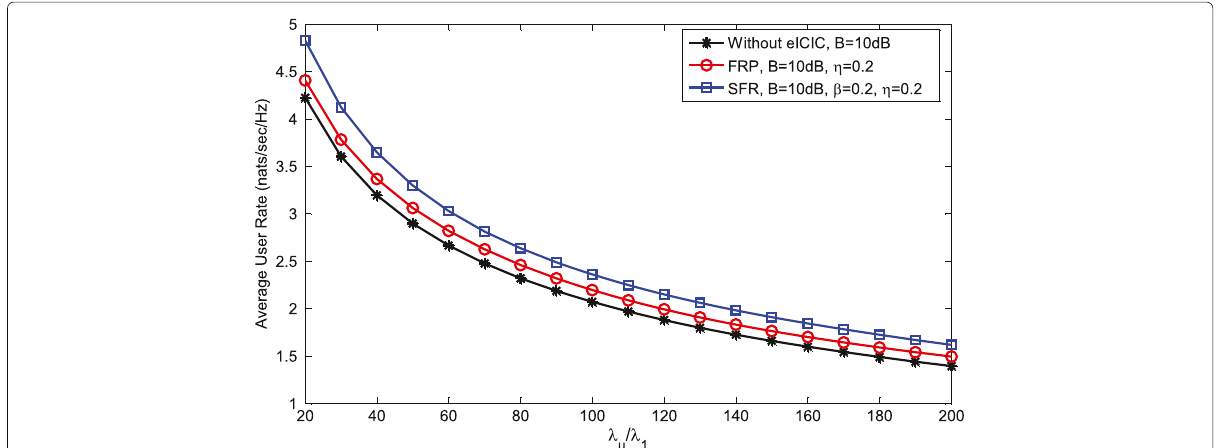
Fig. 3 Comparison of the average user rate of CRE without eICIC, and with FRP and SFR for T FR,1 = T FR,2 = − 10